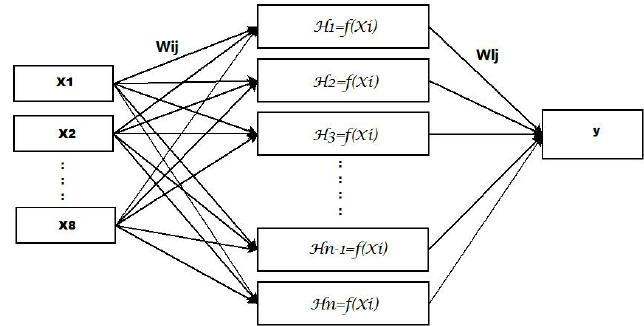
Fig. 2: Original Neural Network